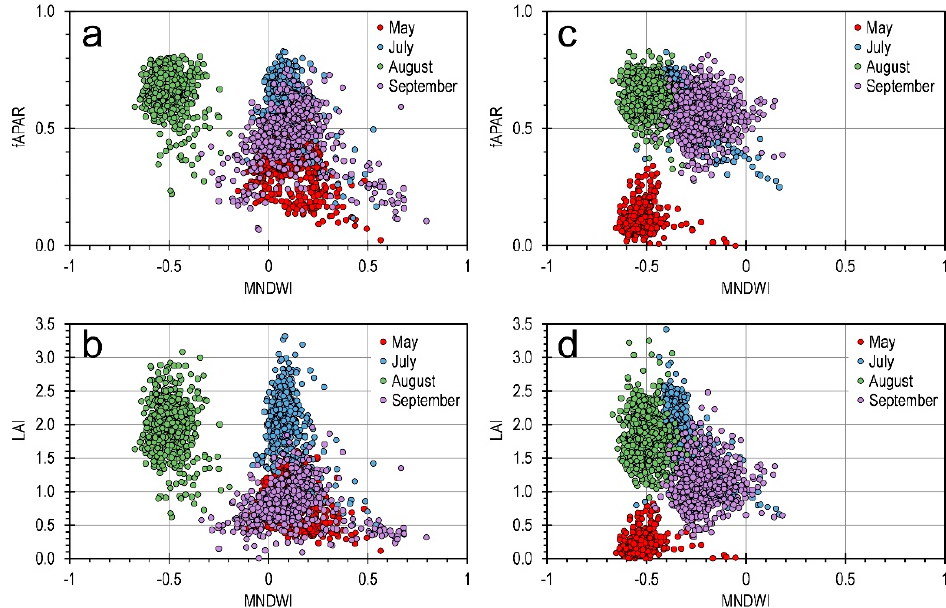
Figure 10. Comparison of Deciduous class LAI and fAPAR vs. MDNWI indices for the 2018 ( a , b ) and 2019 ( c , d ) growing seasons. See Figure 9 for definition of acronyms.